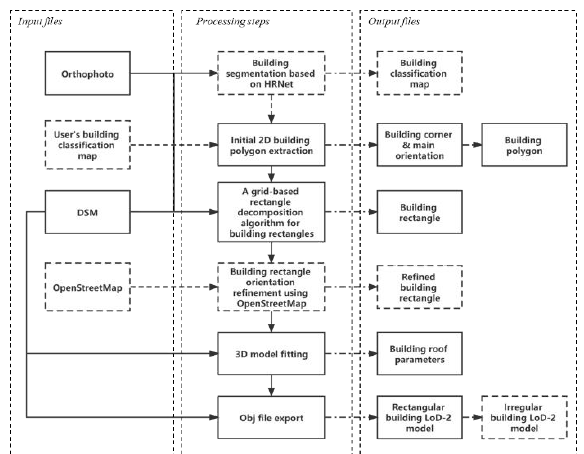
Fig. 1. The workflow of our proposed software, and dotted steps are the optional